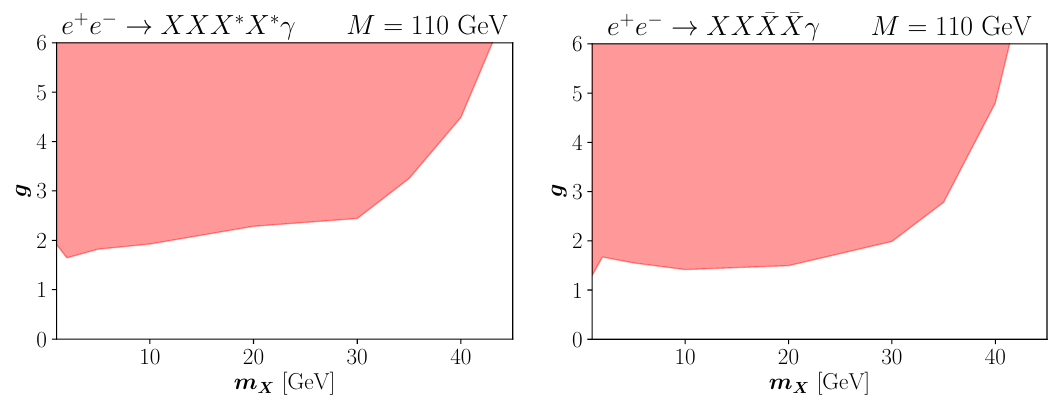
Figure 9 . The red shaded area represents the excluded region in the ( m X ; g ) plane for scalar DM (left) and fermionic DM (right).